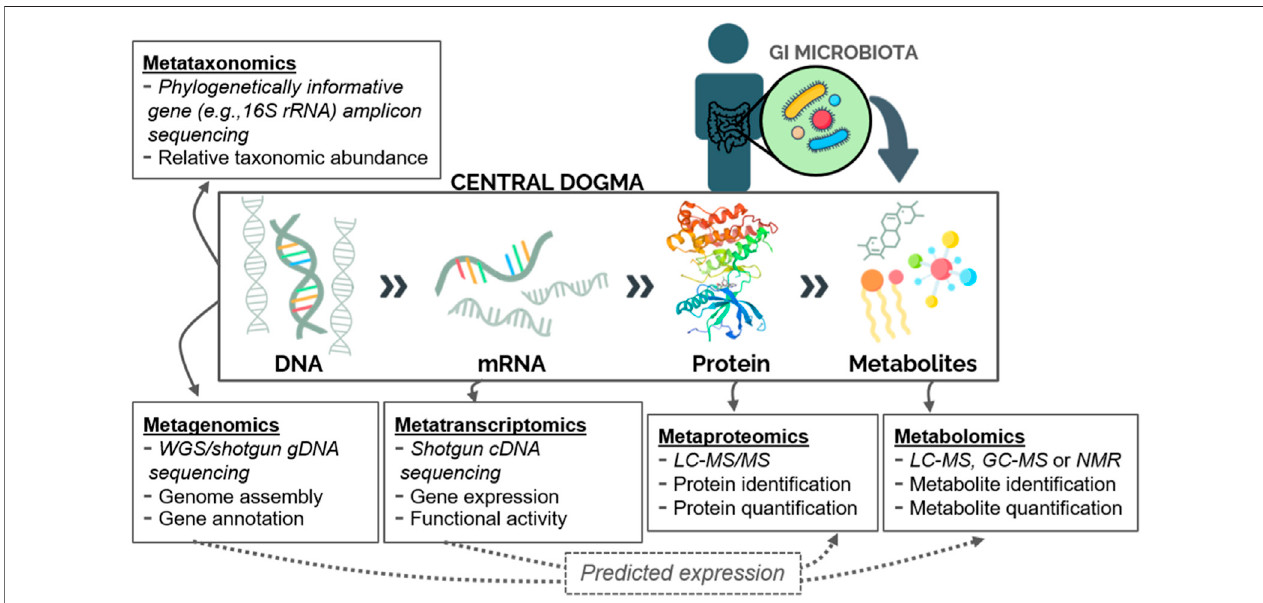
FIGURE 1 | Meta-omics techniques for studying the human gut microbiome. Microbial communities can be characterized based on their collective gene content (metataxonomics or metagenomics), gene transcripts (metatranscriptomics), protein pool (metaproteomics), or metabolite pool (metabolomics). Additionally, sequence data can be used to predict downstream expression of proteins or metabolites (dashed arrows). Abbreviations: WGS: Whole-genome sequencing; LC: Liquid chromatography; MS: Mass Spectrometry; GC: Gas chromatography; NMR: Nuclear magnetic resonance.